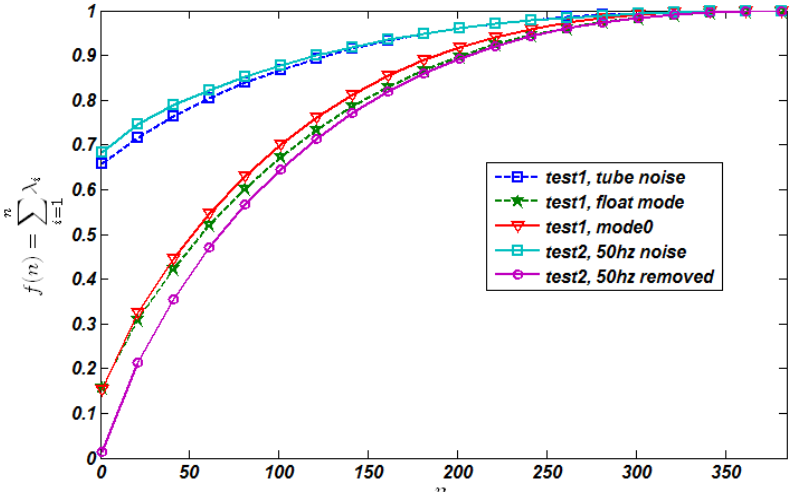
Figure 7. PCA accumulative